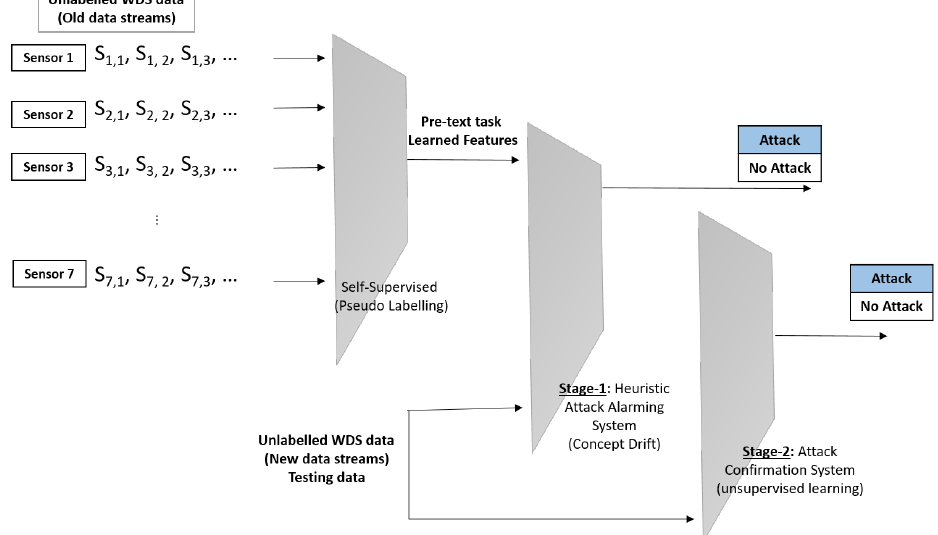
Figure 1. Proposed two-stage detection architecture for alarming and confirming CP